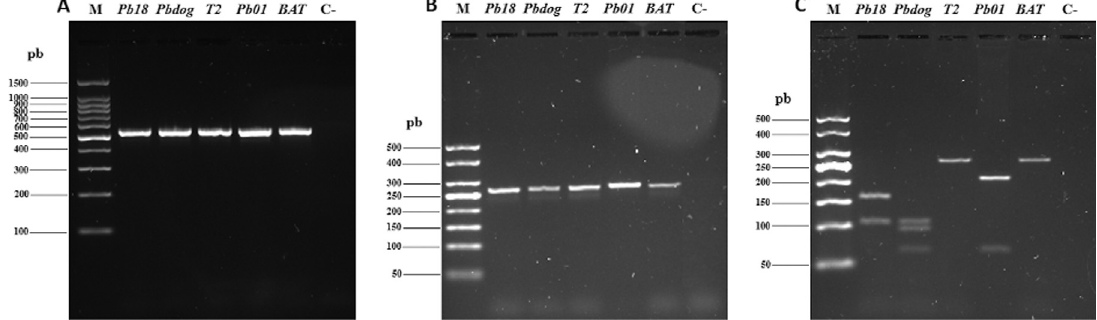
Figure 1 - (A) Partial amplification of the gp43 exon 2 loci of Paracoccidioides spp. by conventional PCR of BAT clinical isolate and reference isolates. M: 100 bp DNA ladder molecular marker, Ready-To-Use (Sinapse® Inc., United States). (B) Amplification of the tub1 gene by PCR-RFLP. M: 50 bp DNA ladder molecular marker (Sinapse® Inc., United States). (C) PCR-RFLP DNA fragment patterns obtained after cleavage with Bcl I and Msp I endonucleases, showing similarity of BAT clinical isolate with T2-EPM54 ( P. restrepiensis – PS3 reference strain). M: 50 bp DNA ladder molecular marker (Sinapse® Inc., United States). Pb 18: P. brasiliensis sensu stricto (S1b); Pb dog-EPM 194: P. americana (PS2); T2-EPM 54: P. restrepiensis (PS3); and Pb 01: P. lutzii ; BAT: Clinical isolate under